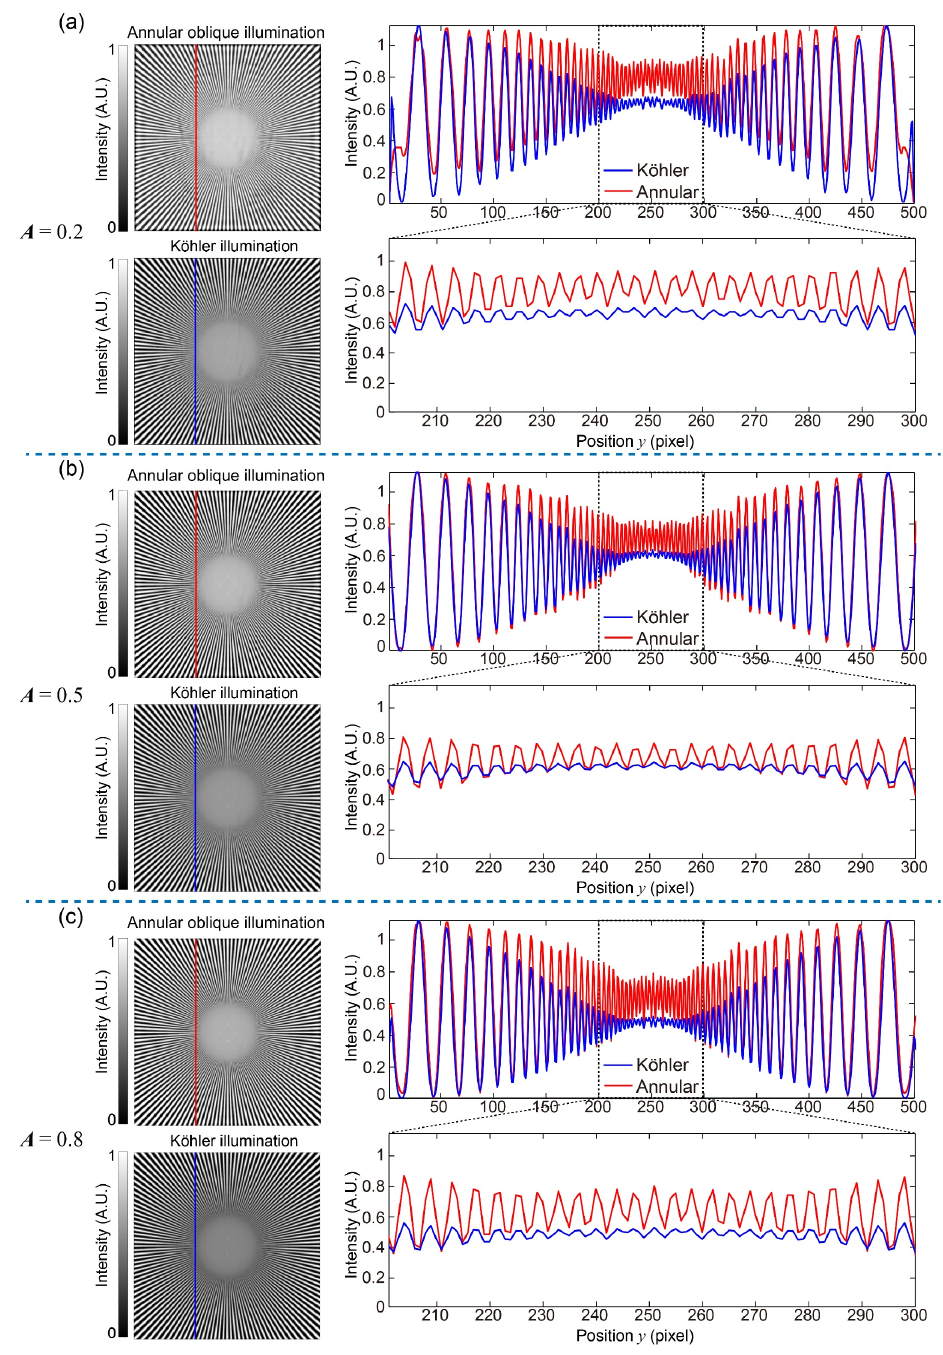
Figure 6. Normalized images: ( a ) A = 0.2, simulated images with intensity distributions at the 170th column, and intensity distributions of 201 to 300 pixels at the 170th column; ( b ) A = 0.5, simulated images with intensity distributions at the 170th column, and intensity distributions of 201 to 300 pixels at the 170th column; ( c ) A = 0.8, simulated images with intensity distributions at the 170th column and intensity distributions of 201 to 300 pixels at the 170th column.